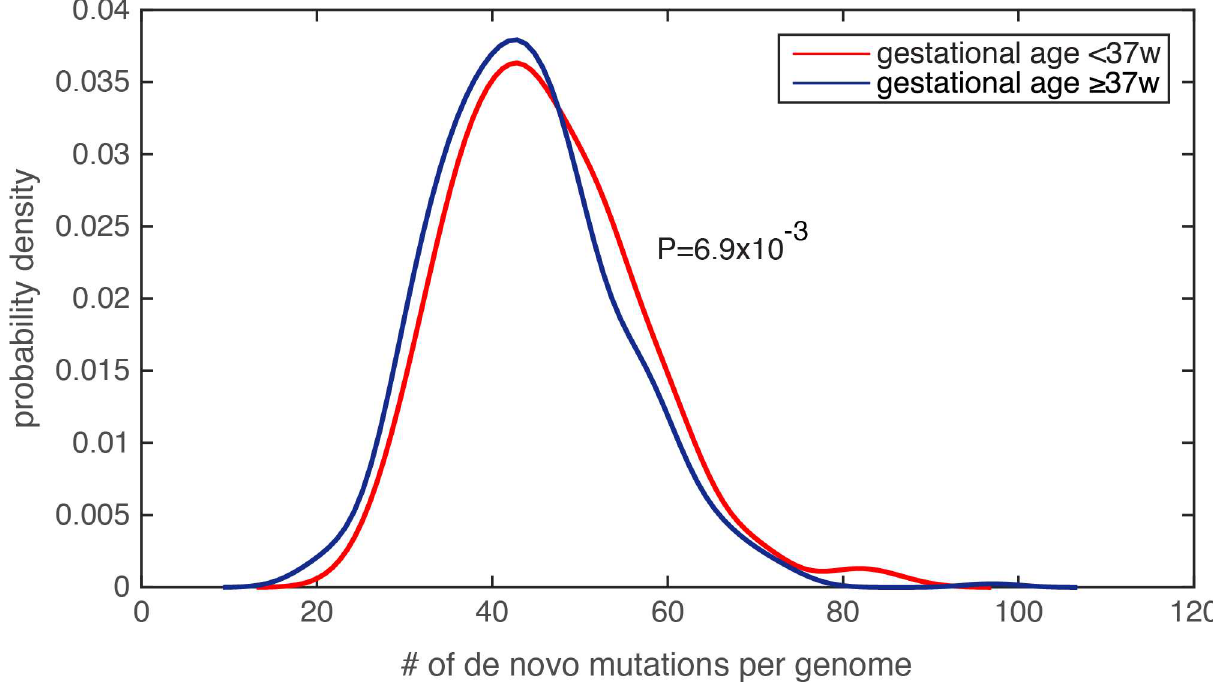
Fig 2. Significantly increased de novo mutation burden in preterm newborn’s genomes. The distribution of the numberof de novo mutations per genomewas comparedbetweenthe PTB and non-PTB cohorts (P = 6.9e-3), and statistical significancewas determined by Wilcoxon rank-sum test. Kernel density estimationwas used to derivethe probabilitydensity